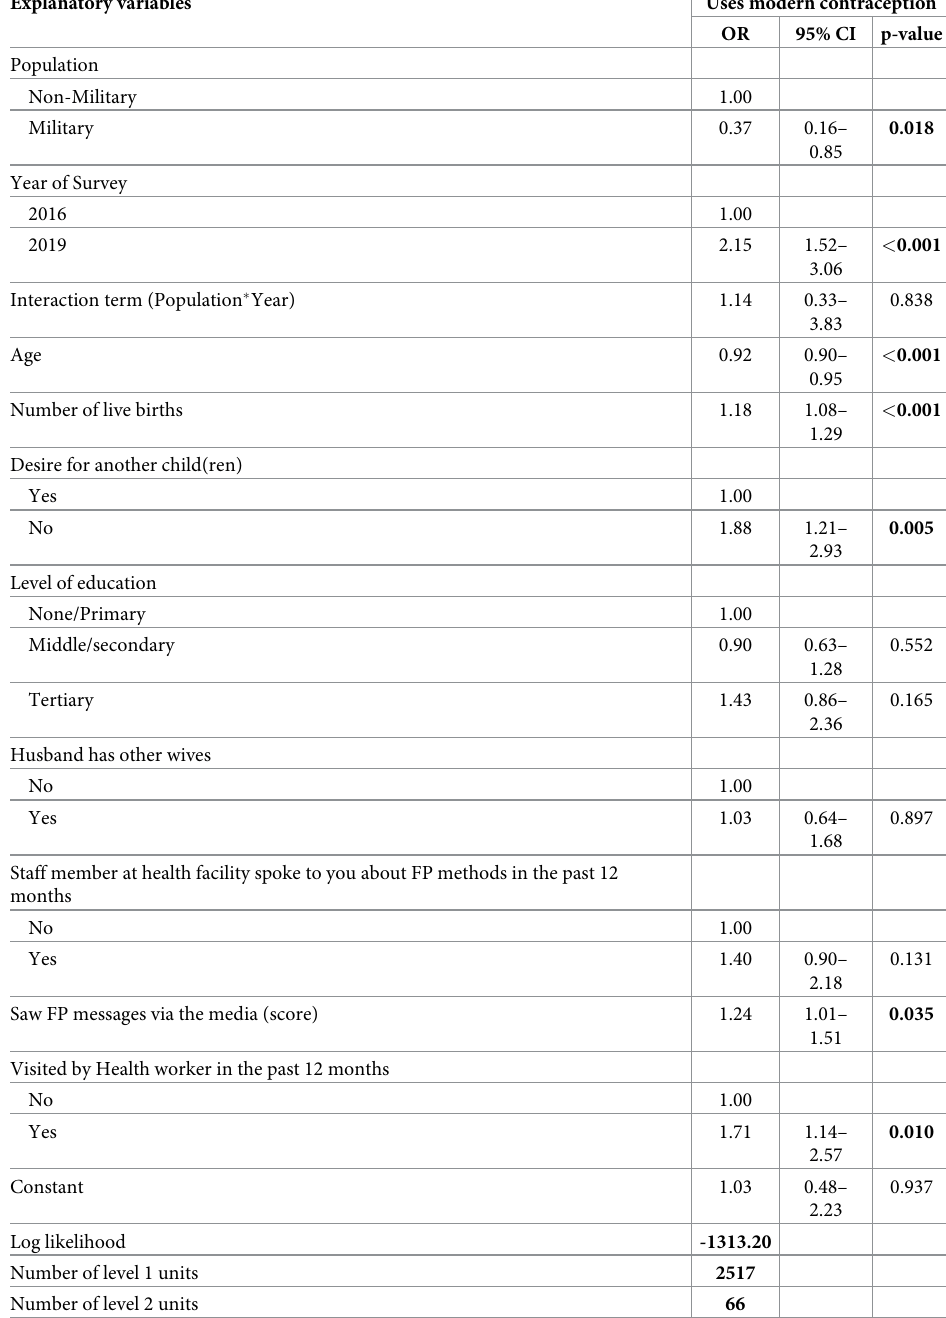
Table 4. Adjusted Odd Ratios (OR) for factors associated with modern contraceptive use in Kinshasa, 2016–2019. Explanatory